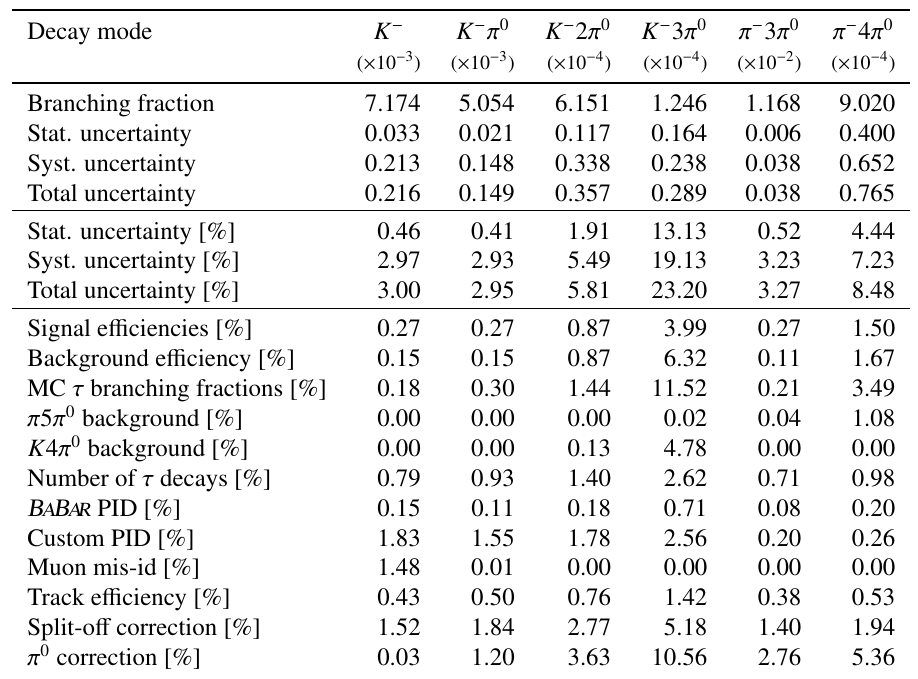
Table 1. Summary of the preliminary measured branching fractions and their uncertainties. Uncertainties that are relative to their branching fraction value are reported as percentages and labelled with “[%]”. The total uncertainty is obtained by adding the statistical and systematic uncertainties in